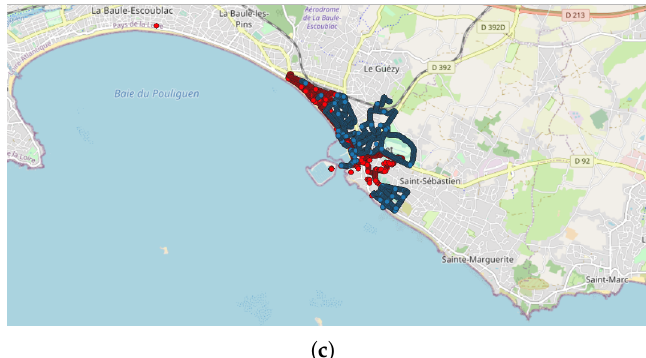
Figure 4. DBSCAN clustering approach, applied to the NC party Id N°1. Due to the scale of the map and because the measurement points are close together, most of the points are stacked, which makes it harder to see all of them individually. Represented area of approximately 6.3 km × 11.5 km: ( a ) representation of line #1 of Table 2 ( Eps = 50 and MinPts = 20): red points represent the main cluster; the other colors represent the secondary clusters; all NC points are grouped in 7 clusters but mainly in one main cluster (red) and one secondary cluster (yellow); ( b ) representation of line #2 of Table 2 ( Eps = 50 and MinPts = 100): red points represent the main cluster; yellow points represent the secondary cluster; black points represent the non-clustered data; all NC points are included in 2 clusters, the main and a secondary one; ( c ) representation of line #10 of Table 2 ( Eps = 3000 and MinPts = 20); all data are located in only one cluster: red points represent all the points of the NC party Id N°1 that are part of the cluster; blue ones represent the extra data that are part of the same cluster, but not from the NC party.